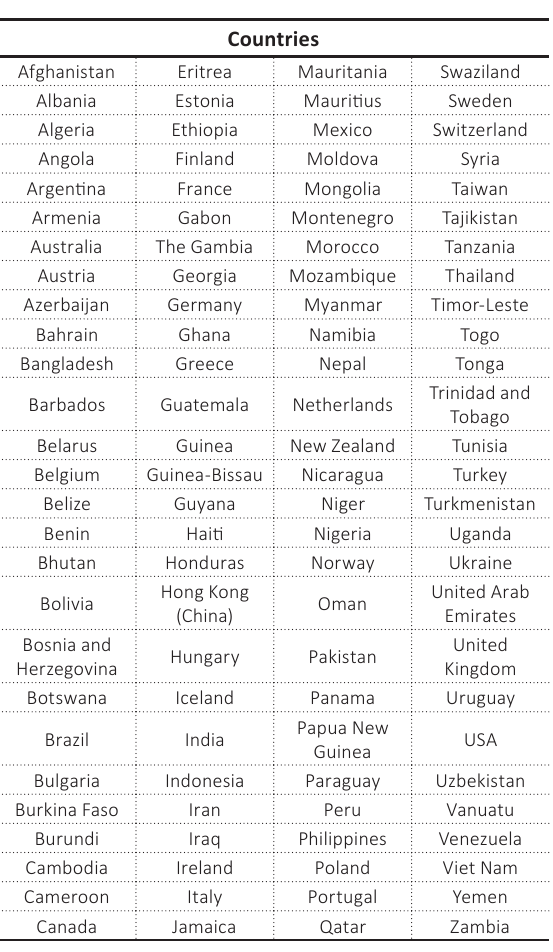
Table 1. List of